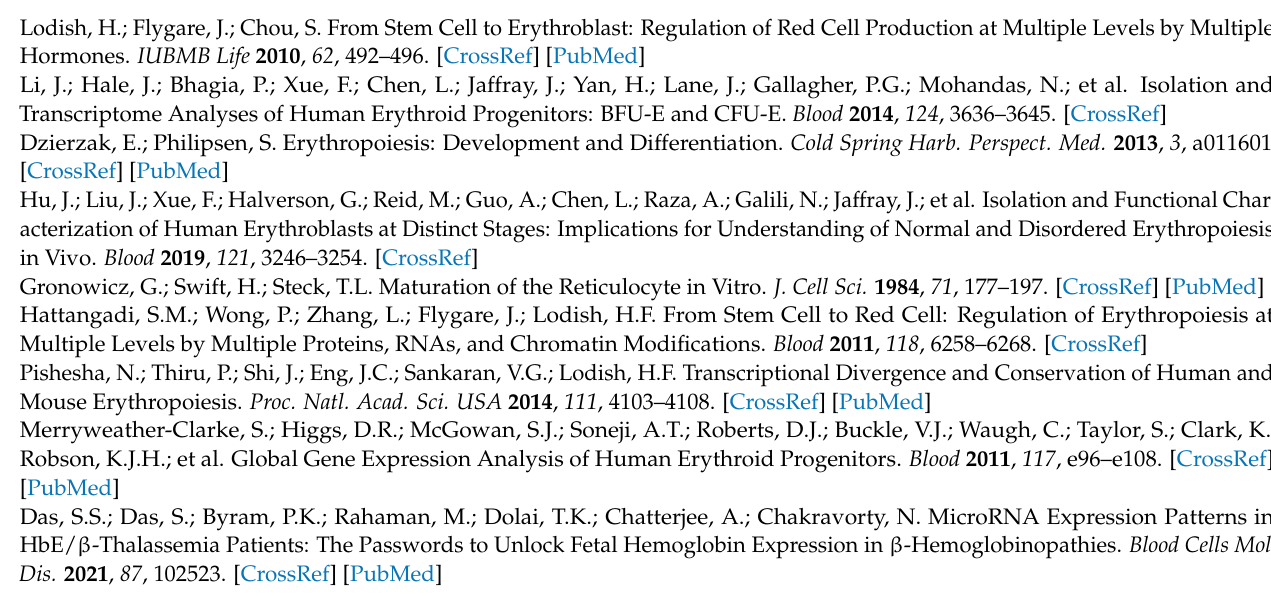
Table S1. Sequences of the forward primers used for real-time PCR analysis of miRNA expression, Table S2. miRNAs with significant differential expression during erythropoiesis (log2FC > − 2 or <2, p < 0.01). Table S3: Previously reported miRNAs involved in erythropoiesis identified in this study, Table S4. Molecular functions and pathways of the upregulated genes targeted by multiple downregulated miRNAs, Table S5. Molecular functions and pathways of the downregulated genes targeted by multiple upregulated miRNAs. Table S6. Real-time PCR analysis after miRNA KO in HUDEP2 cells. ∆ Ct = Ct of target-Ct of U6 (control). ∆∆ Ct = ∆ Ct in the KO cells- ∆ Ct in the control cells. FC = fold change in the expression calculated by the 2 − ∆∆ CT method. * When the Ct values were undermined due to very low expression, a value of 40 was denoted for